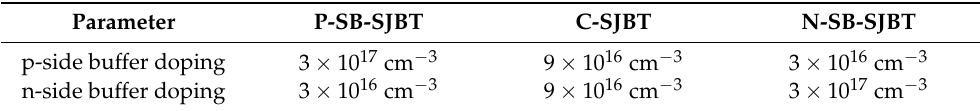
Table 2. Buffer doping concentration according to each structure.